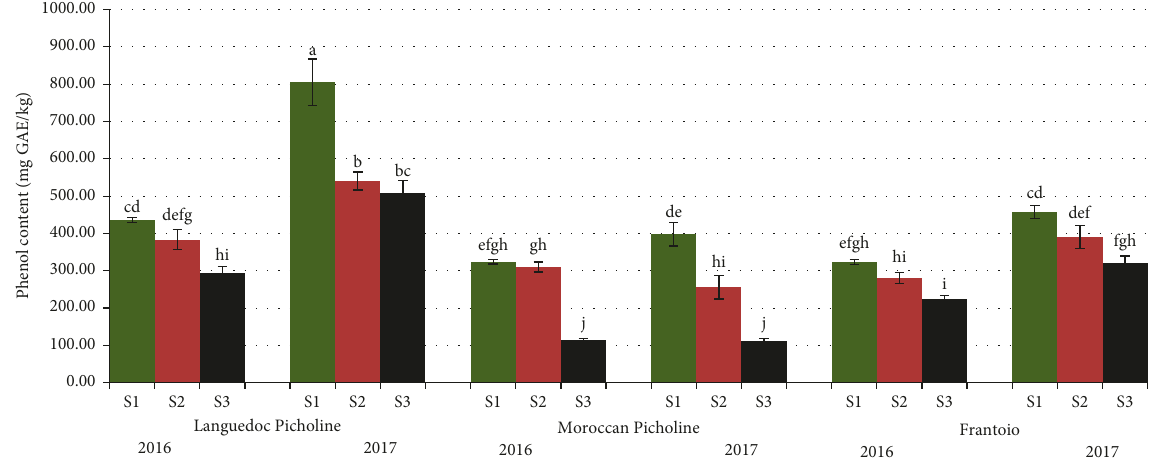
Figure 8: Phenol content in virgin olive oils of three cultivars grown in Marrakech (Morocco) at different stages of maturity (S1: green; S2: purple; S3: black). Values are means ± standard deviation (SD) of three replications. Data followed by different letters are significantly different from each other ( P < 0 . 05) according to LSD